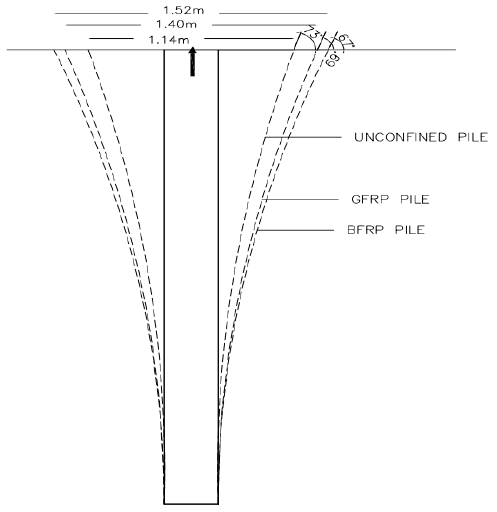
Figure 18. Failure envelope during the uplift.